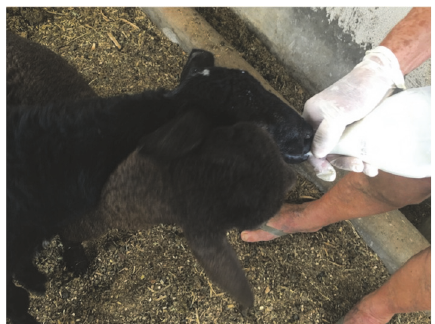
Figure 5: Patient feeding the kids using